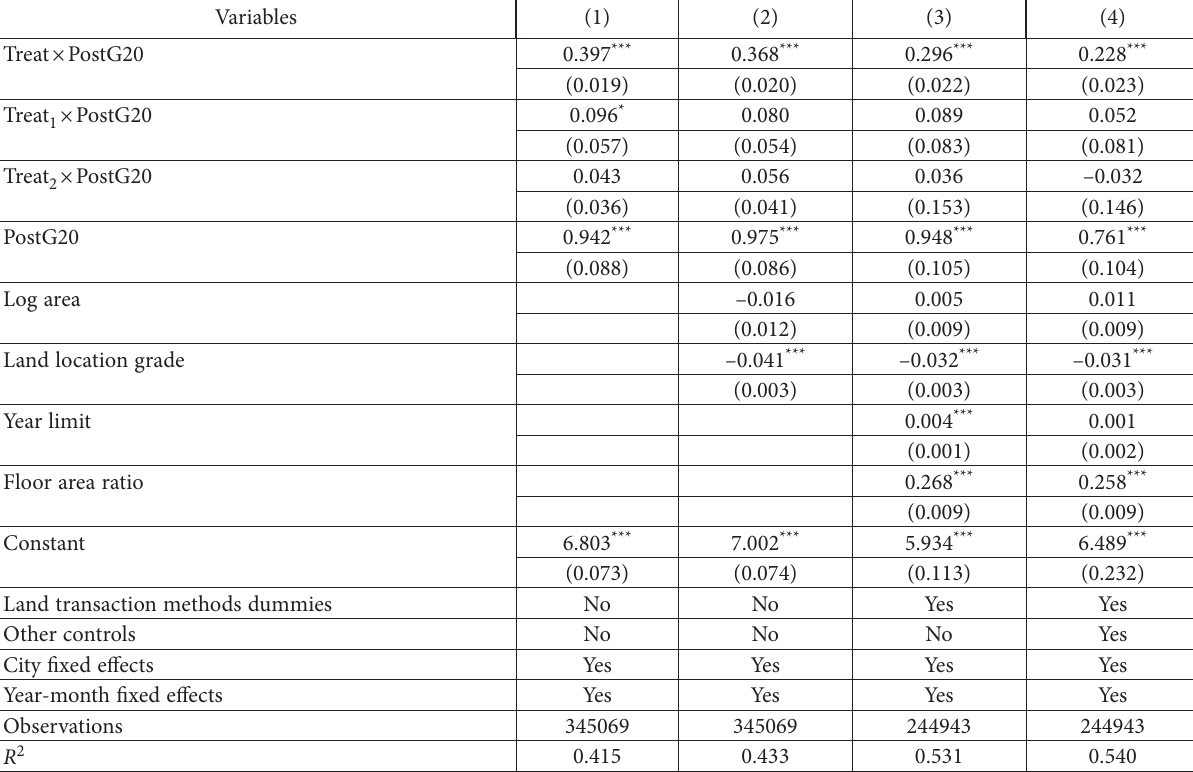
Table 4. Heterogeneous effect of hosting the G20 Summit on land prices Variables